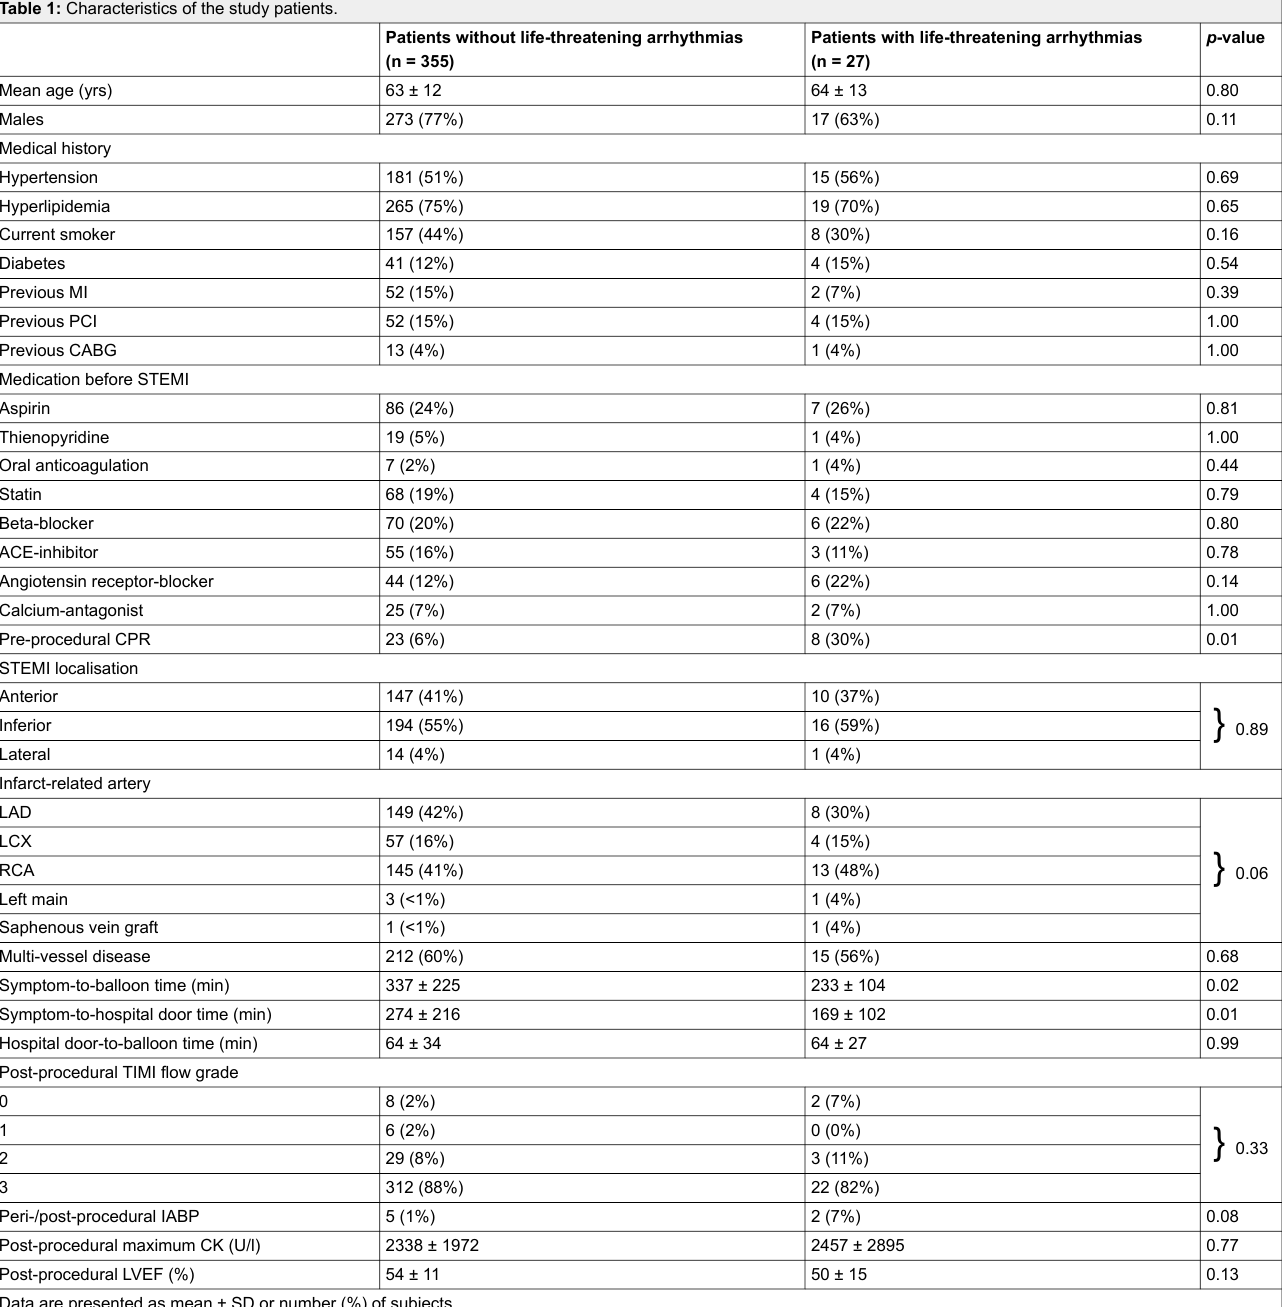
Table 1: Characteristics of the study patients.